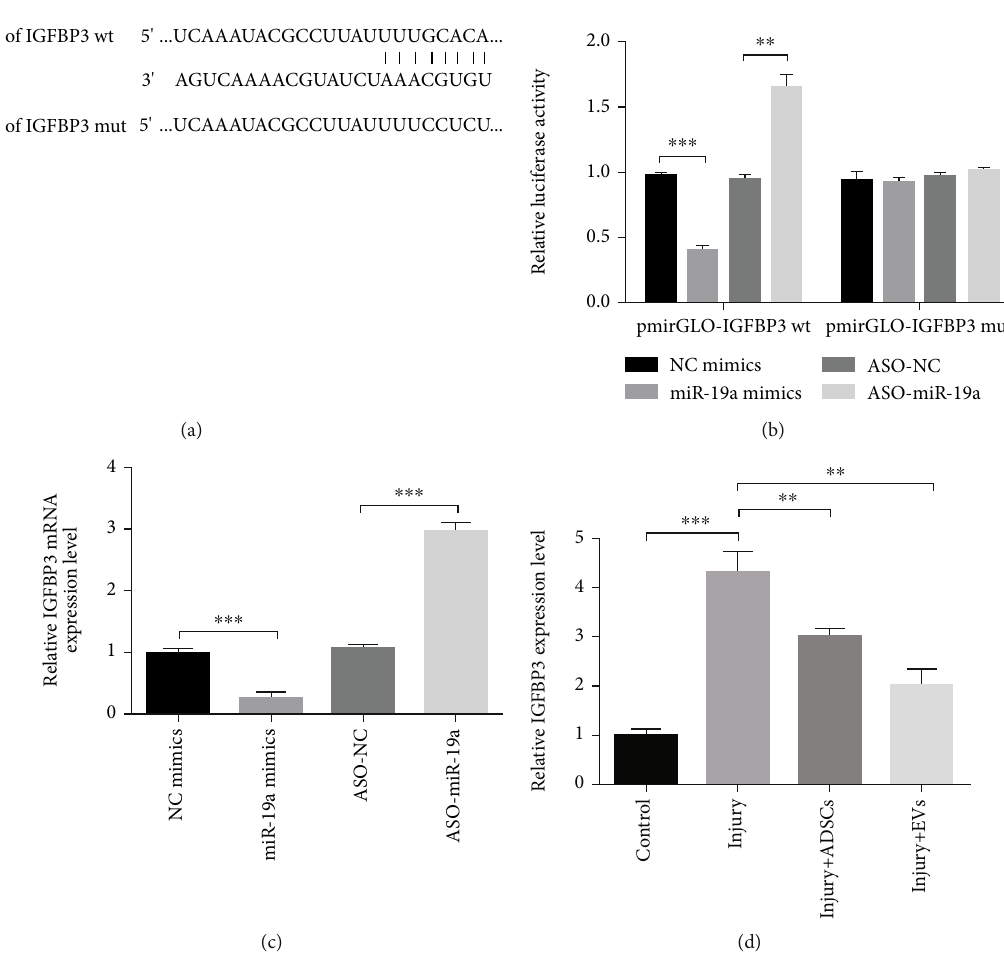
Figure 5: EV-derived miR-19a inhibited IGFBP3 expression through targeting its 3 ′ UTR. (a) Putative binding sites of miR-19a and IGFBP3 mRNA 3 ′ UTR were predicted by DIANA-LncBase V2 and Targetscan. (b) Luciferase reporter analysis was performed to detect the bindings between miR-19a and IGFBP3 in tendon cells. (c) The e ff ect of miR-19a intervention on the expression of IGFBP3 in tendon cells was evaluated using qRT-PCR. (d) The expression of IGFBP3 was evaluated using qRT-PCR in the injury group, injury+ADSCs, and injury +EV groups ( ∗ P < 0 : 05 , ∗∗ P < 0 : 01 , and ∗∗∗ P < 0 : 001